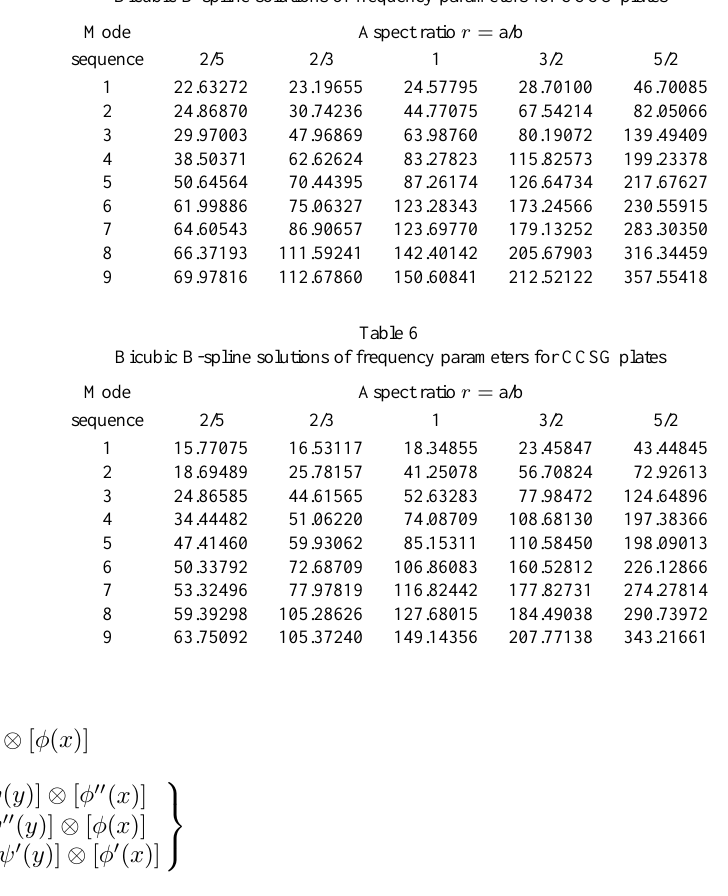
Table 5 Bicubic B-spline solutions of frequency parameters for CCCG plates